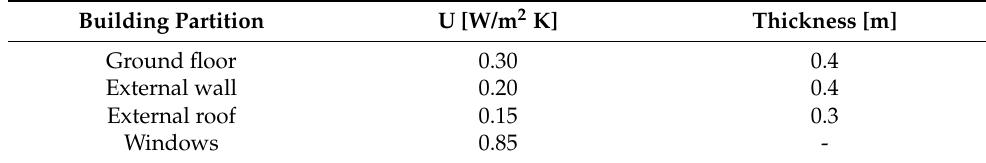
Table 1. Characteristic of building envelope.